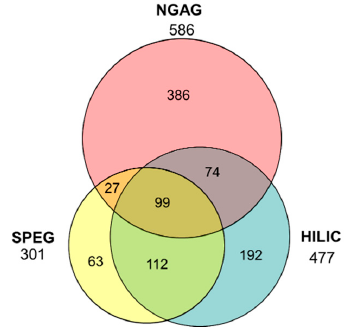
Figure 2. N -Glycosites identified from the CHO secretome. SPEG and HILIC showed greater overlap in identified glycosites than NGAG, which exhibited considerable orthogonality. Overall, NGAG identified the largest number of glycosites (586) from the CHO secreted proteome with HILIC identifying 477 and SPEG